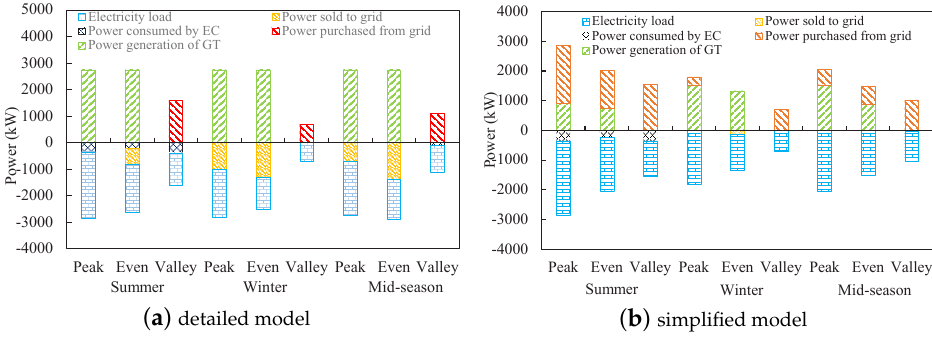
Figure 7. Electricity optimization results as for Case